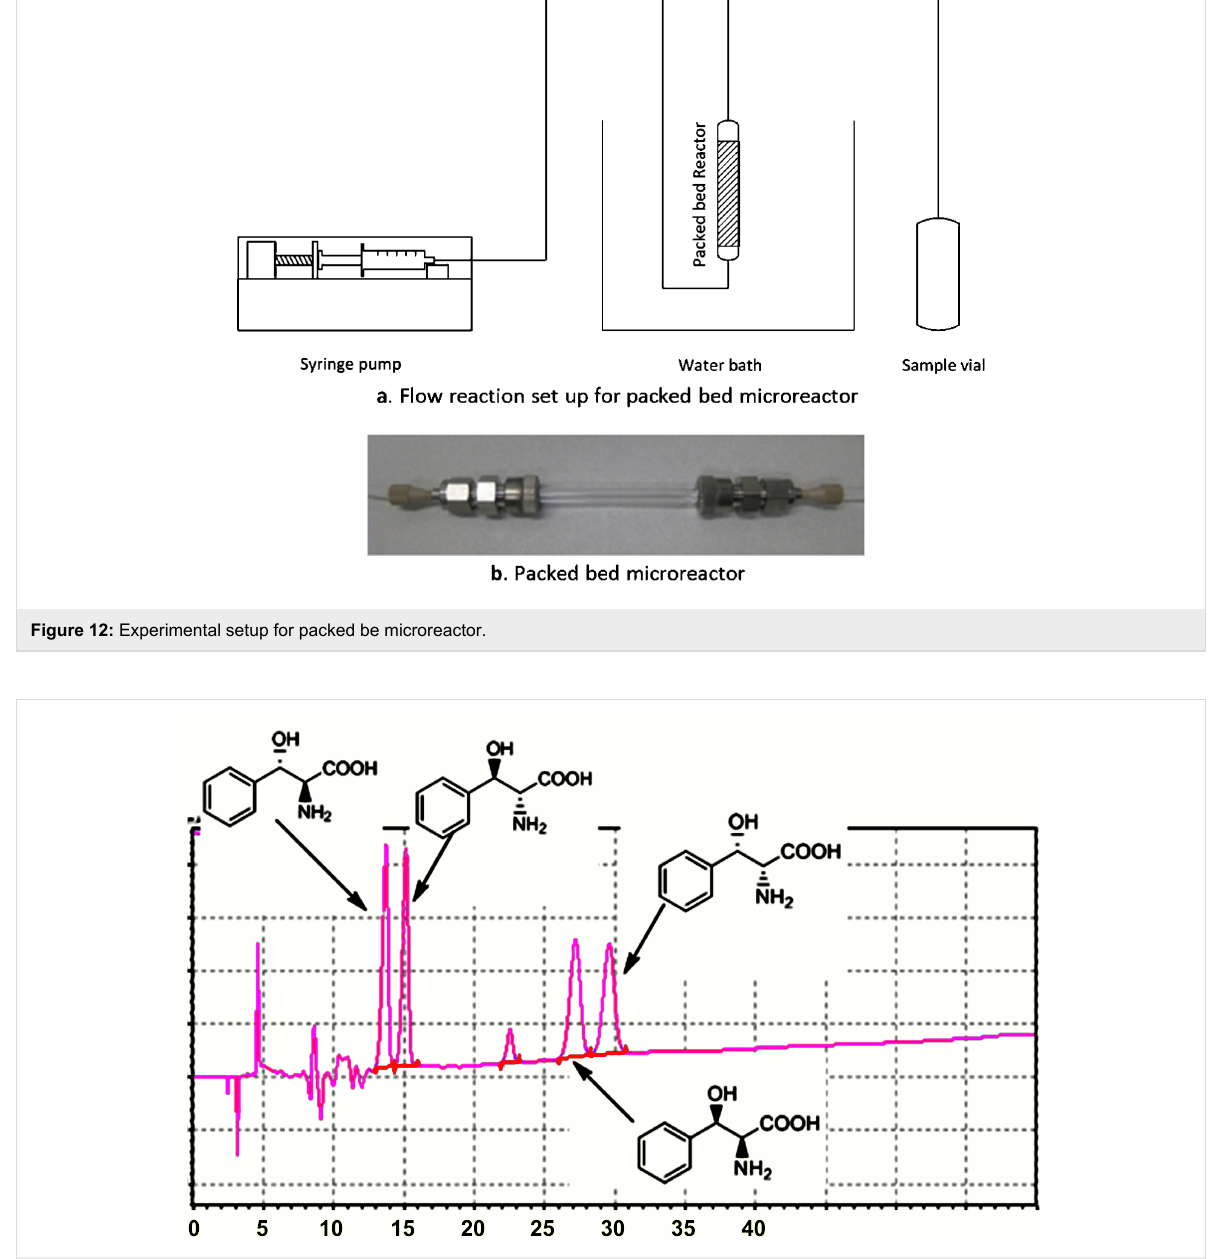
Figure 13: Analysis of the four isomers of phenylserine on a chiral